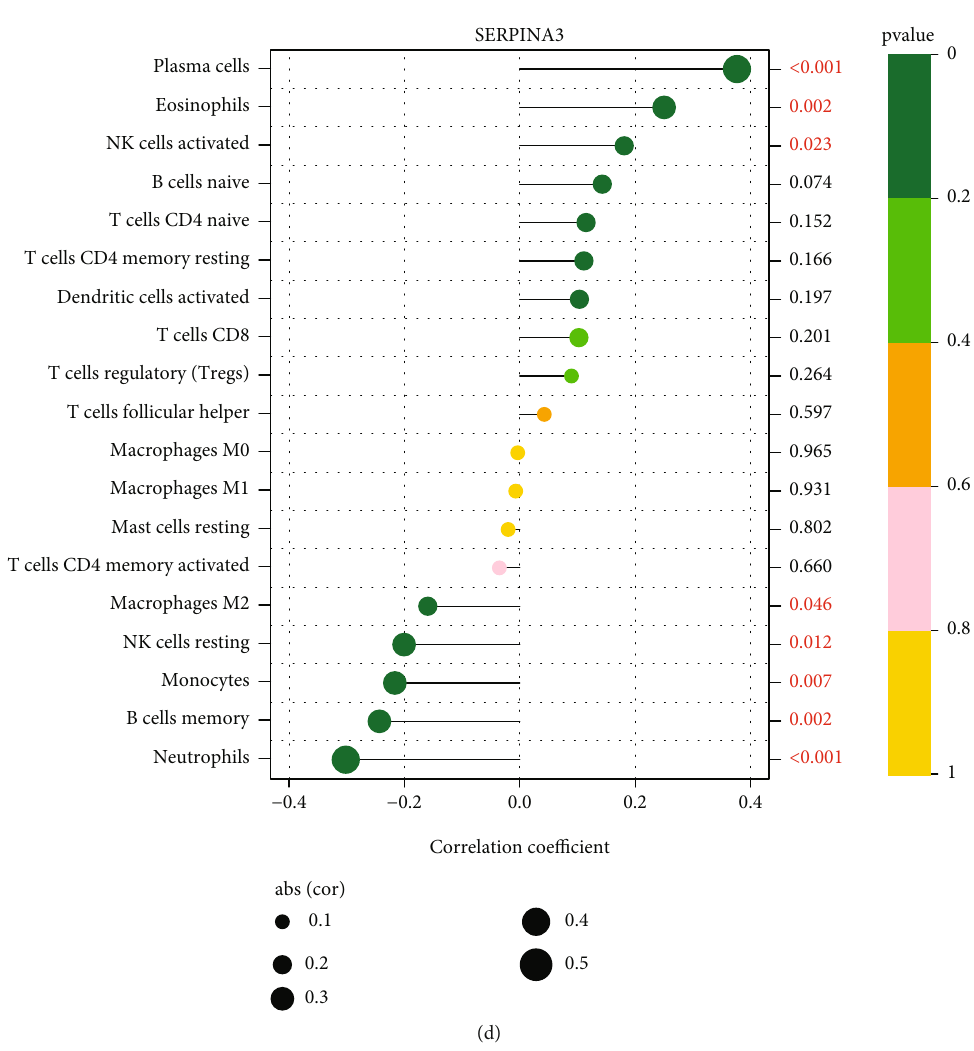
Figure S1: correlation of the immune cell percentage with the expression of COL17A1 in preeclampsia. Figure S2: cor- relation of the immune cell percentage with the expression of FLT1 in preeclampsia. Figure S3: correlation of the immune cell percentage with the expression of FSTL3 in pre- eclampsia. Figure S4: correlation of the immune cell percent- age with the expression of SERPINA3 in preeclampsia. Table S1: the abnormally expressed genes in preeclampsia. Table